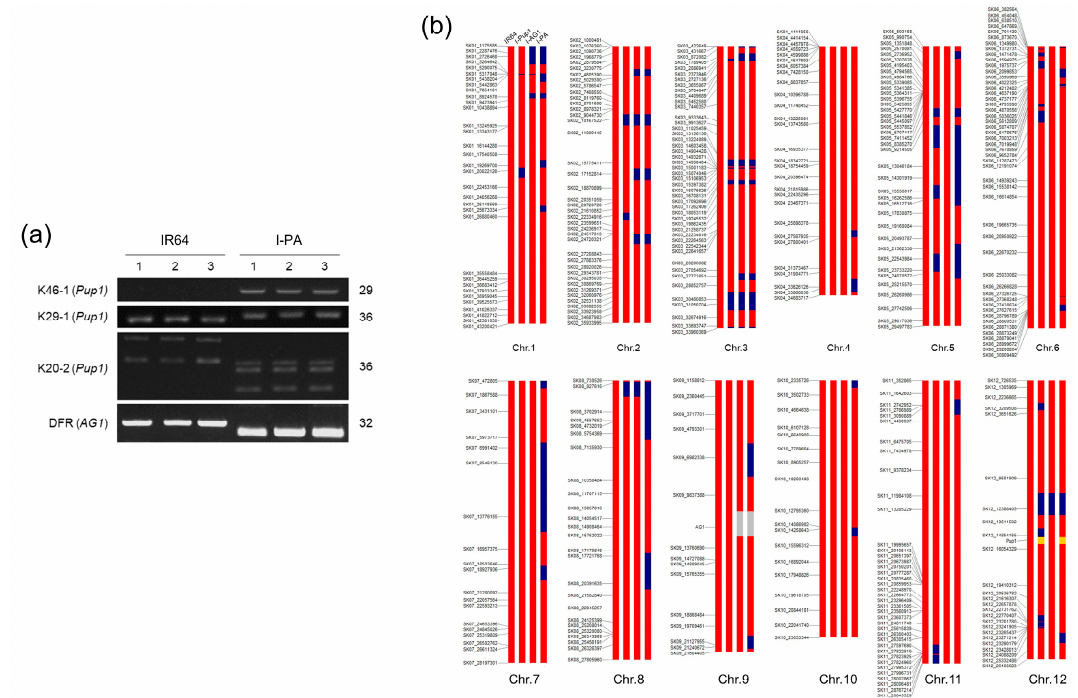
Figure 1. Development and selection of IR64-Pup1-AG1 (I-PA). ( a ) Foreground genotyping using Pup1 and AG1 QTL gene-specific markers. ( b ) Background genotype of I-PA and near isogenic lines (NILs). Blue bar: unique regions of NILs against IR64; grey bar: AG1 QTL; yellow bar: Pup1